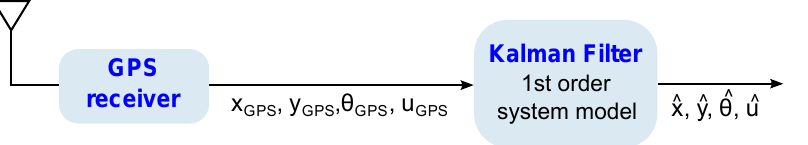
Figure 6. Black box diagram of the system